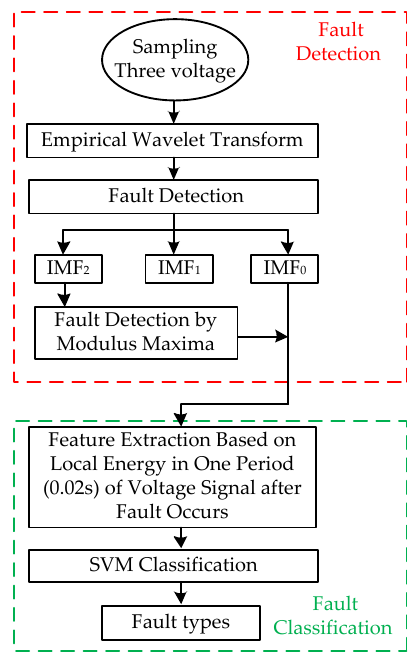
Figure 2. Flow chart of the proposed approach.